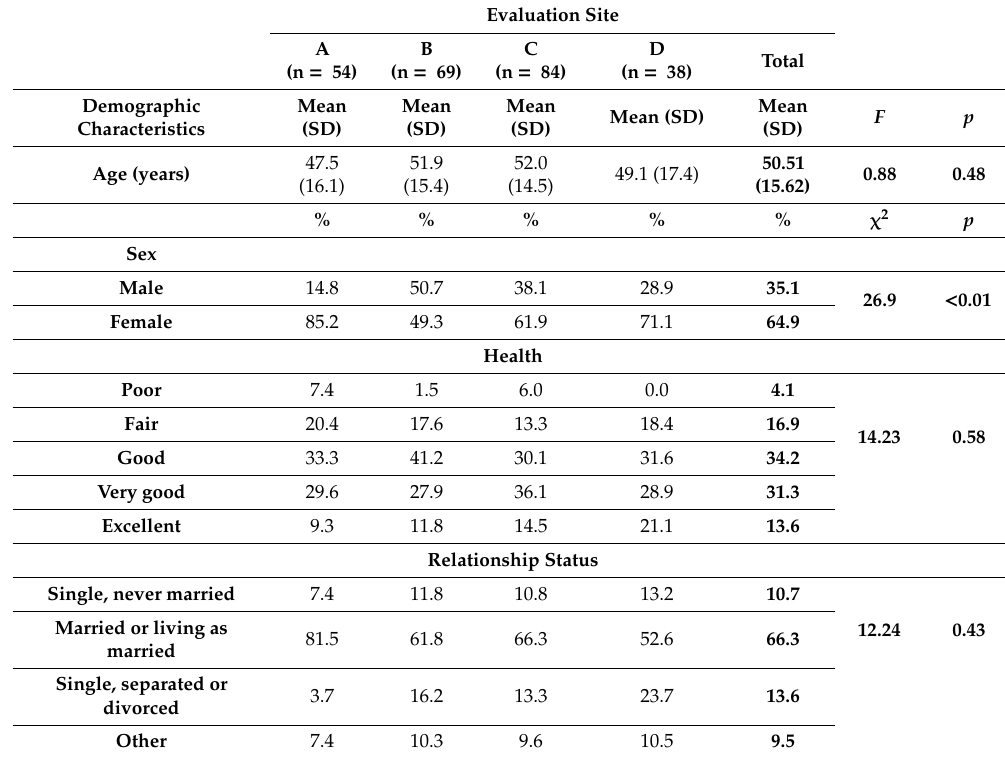
Table 2. Demographic characteristics of survey participants (n = 245) by evaluation